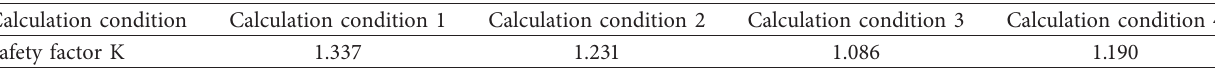
Table 9: Overall stability calculation results of the